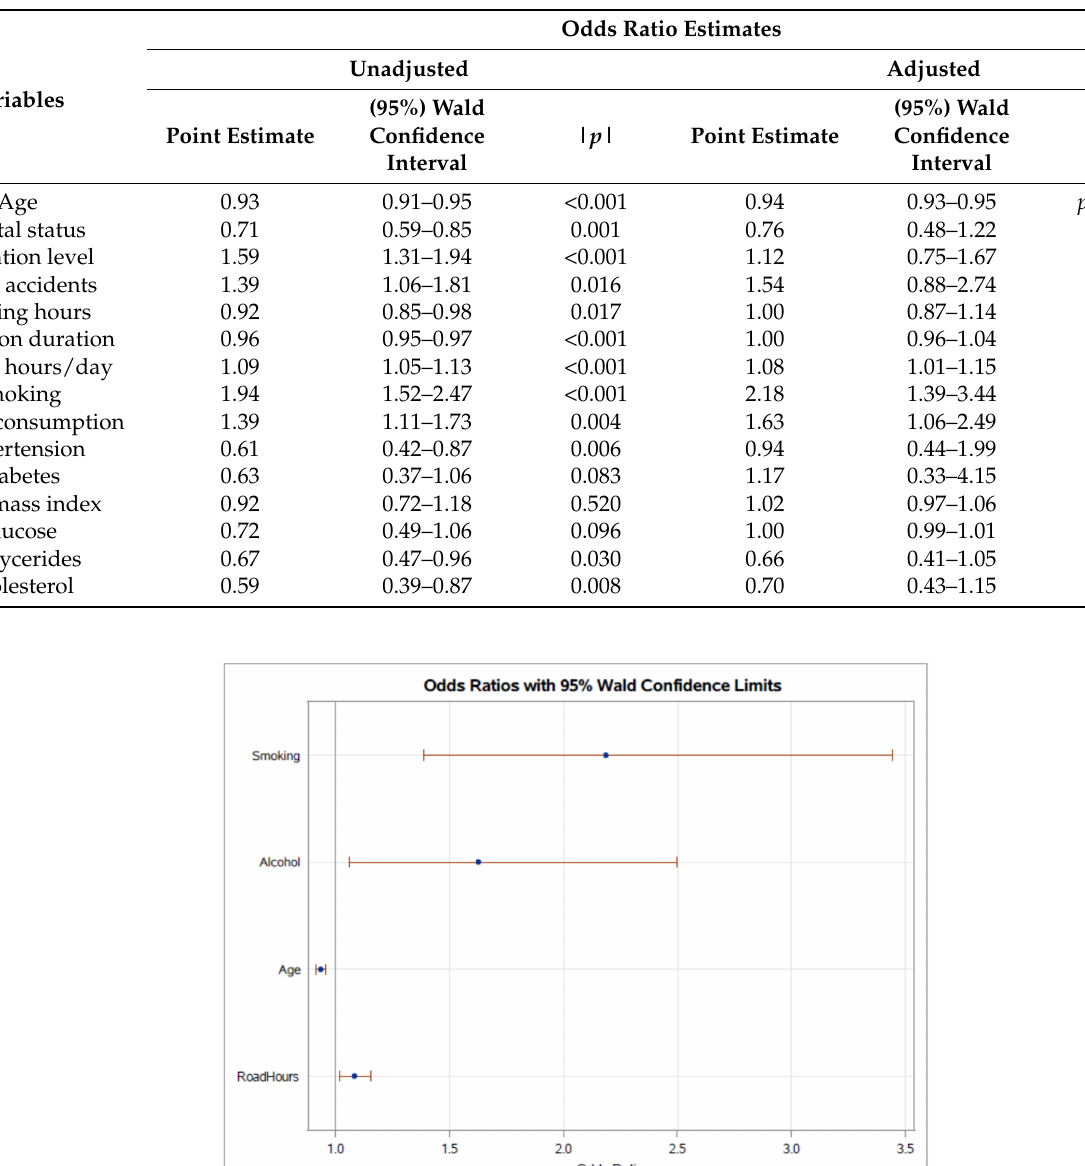
Table 2. Logistic regression analysis of unadjusted and adjusted odds ratio and 95% Wald confidence limits of the data collected from 2071 truck drivers, classified according to the self-report of consumption of illicit drugs.